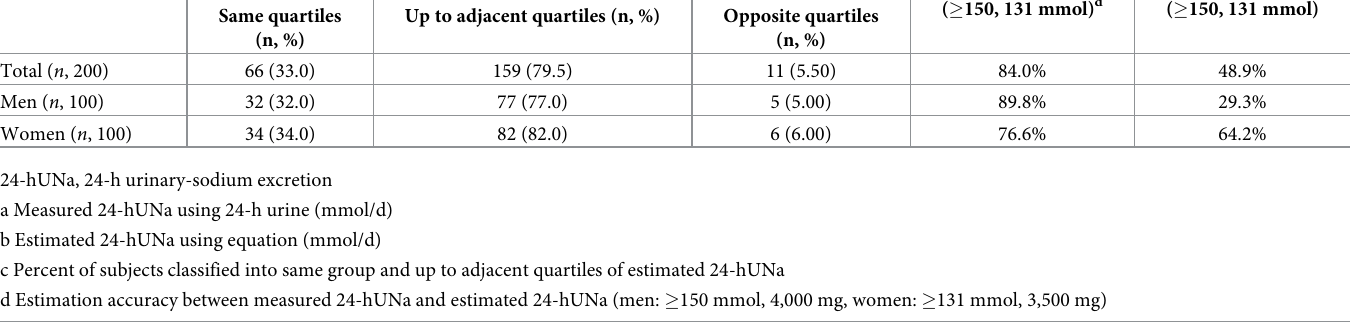
Table 3. Estimation accuracy between measured 24-hUNa a and estimated 24-hUNa b (validation set, study 2). Validation